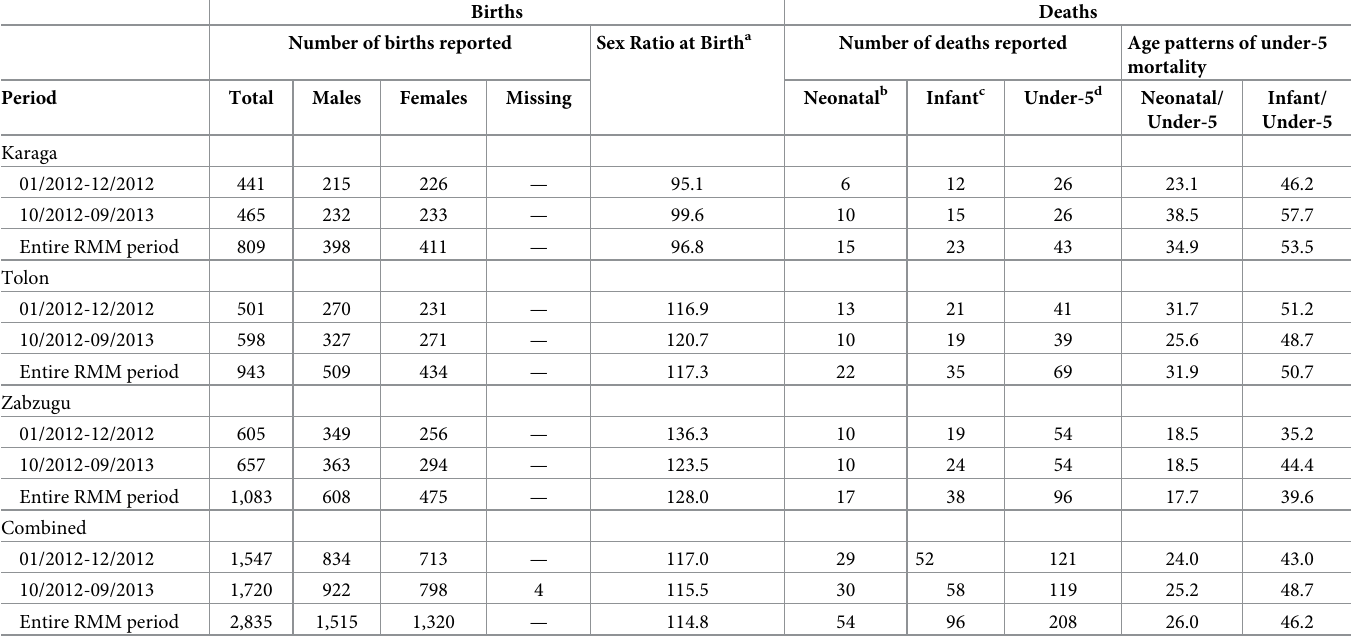
Table 3. Assessments of the quality of FPH data, by district and study